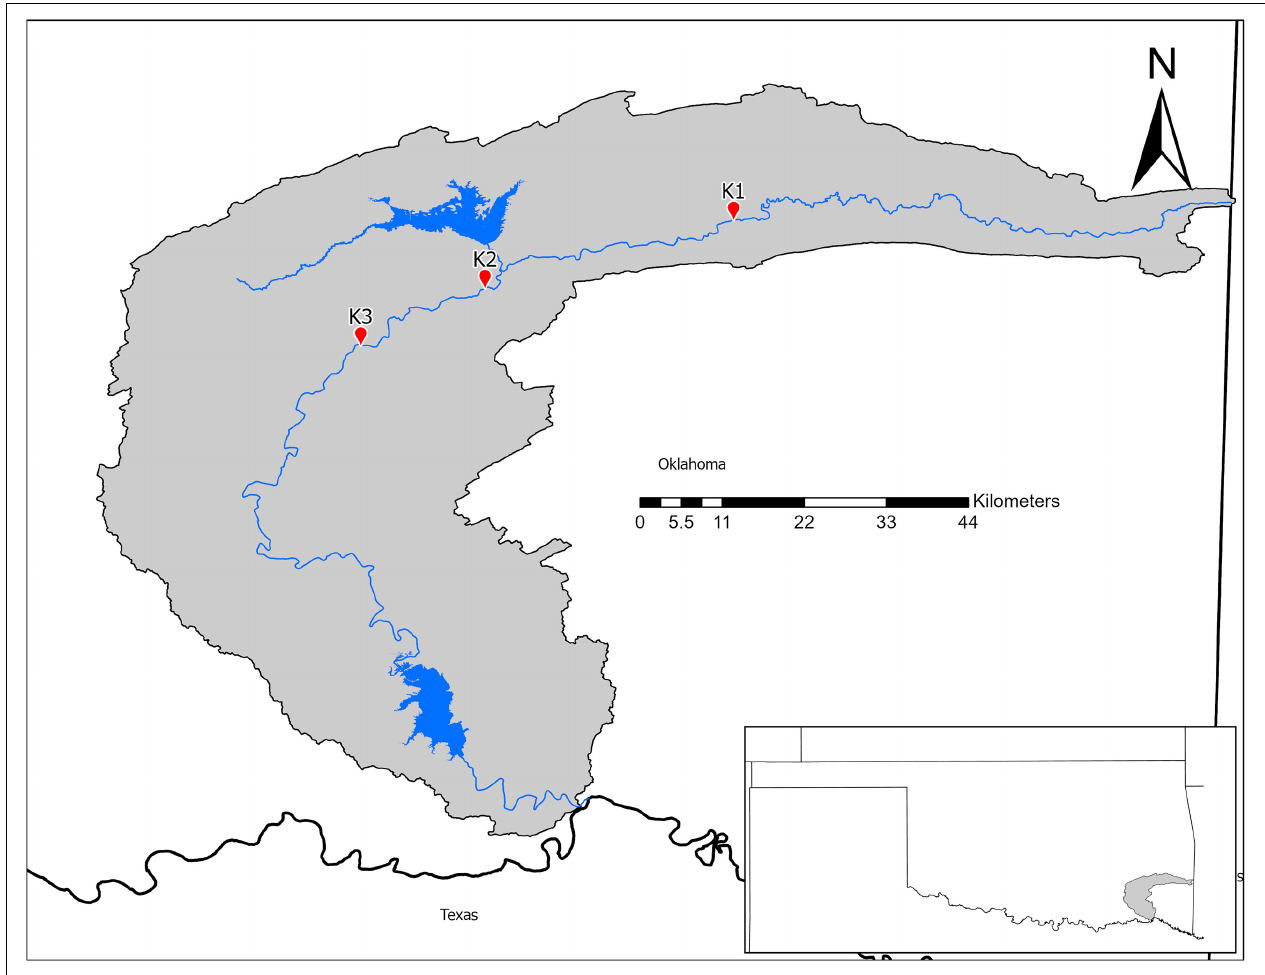
FIGURE 1 | Map of the Kiamichi River drainage in Southeastern